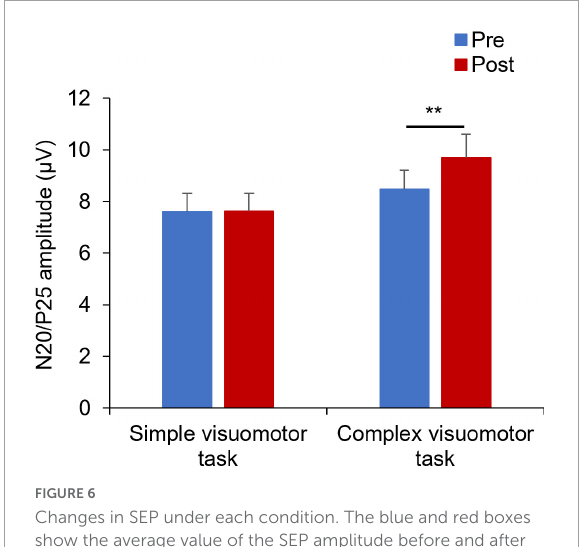
FIGURE6 Changes in SEP under each condition. The blue and red boxes show the average value of the SEP amplitude before and after each condition intervention, respectively. In the complex visuomotor task alone, the SEP amplitude increased after motor learning. ** p < 0.01 (vs.